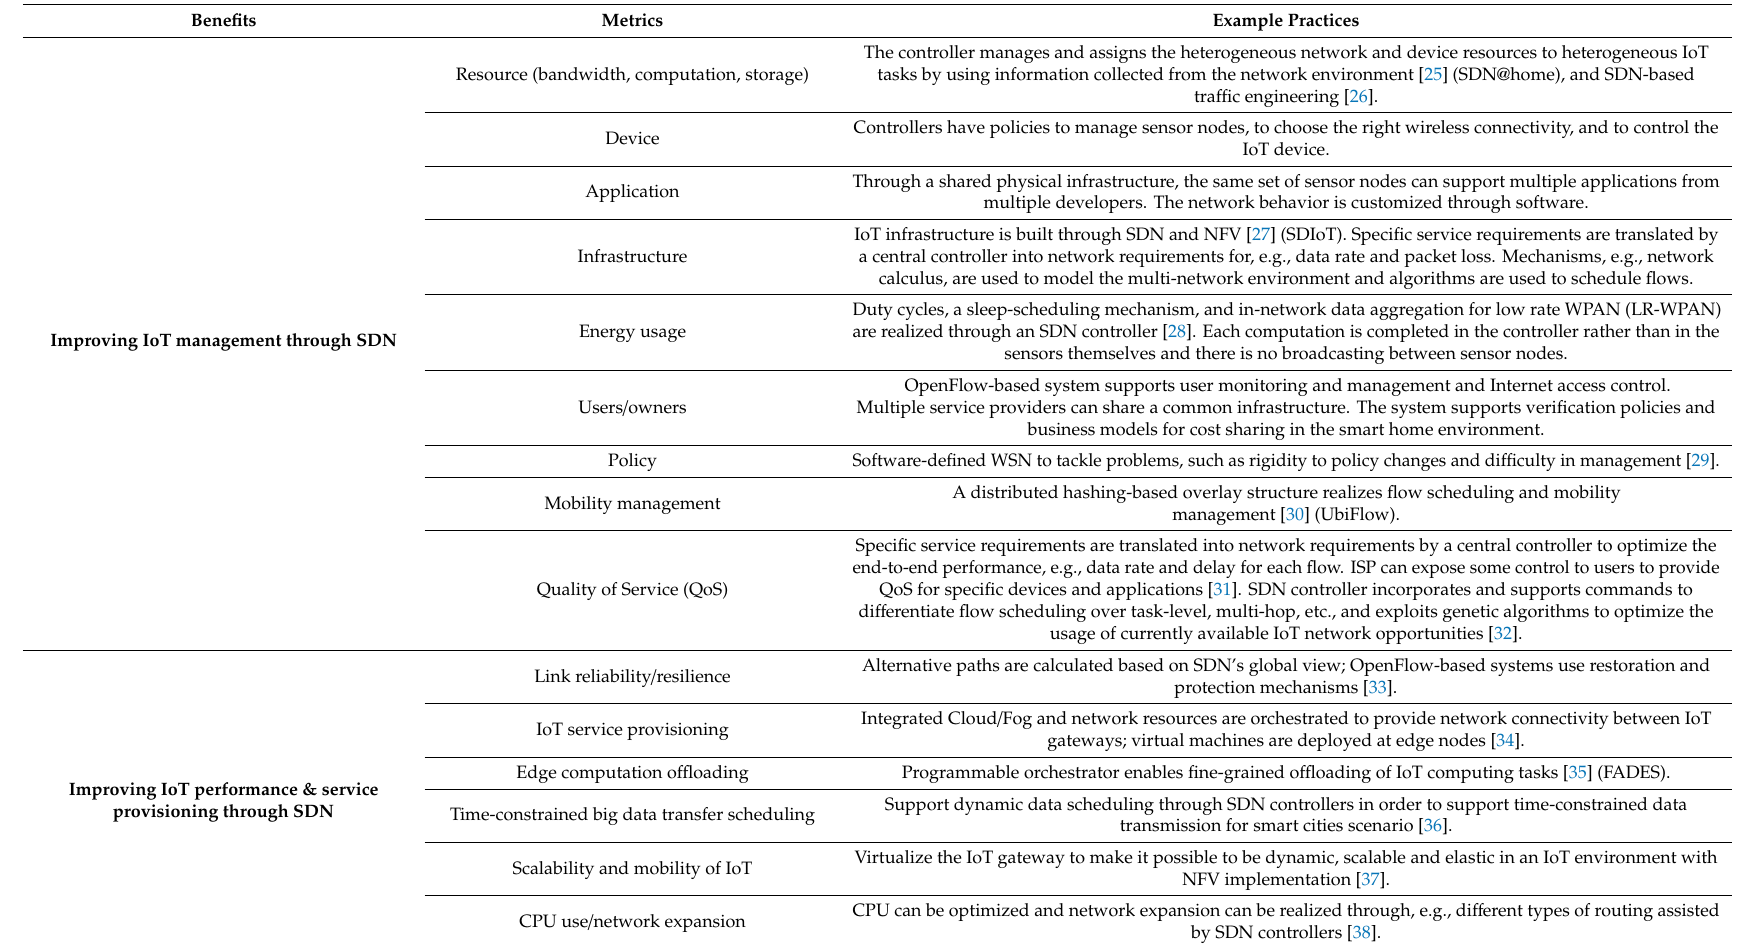
Table 2. Benefits of SDN to